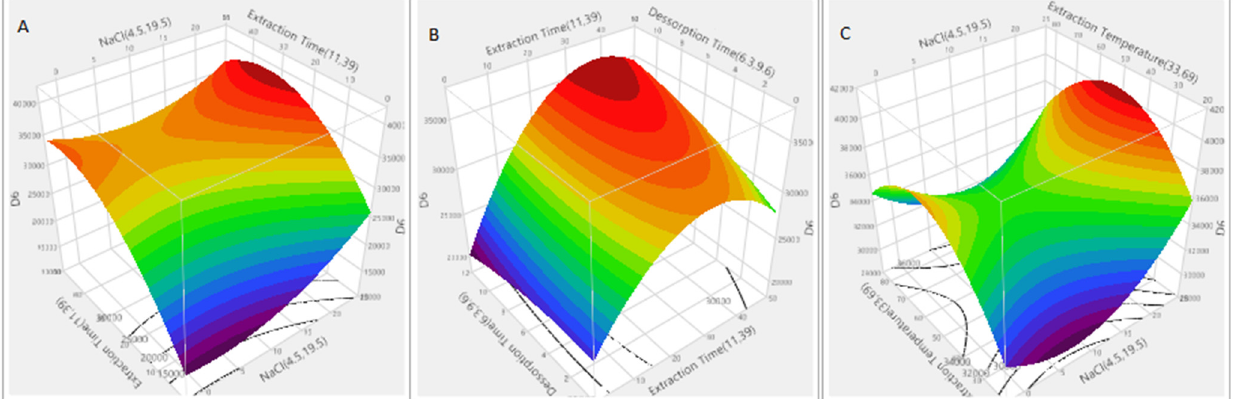
Figure 3. Examples of response surface plots for D6: ( A ) effect of extraction time and ionic strength (% NaCl) on peak area; ( B ) effect of extraction and desorption time on peak area; ( C ) effect of extraction temperature and ionic strength (% NaCl) on peak area.